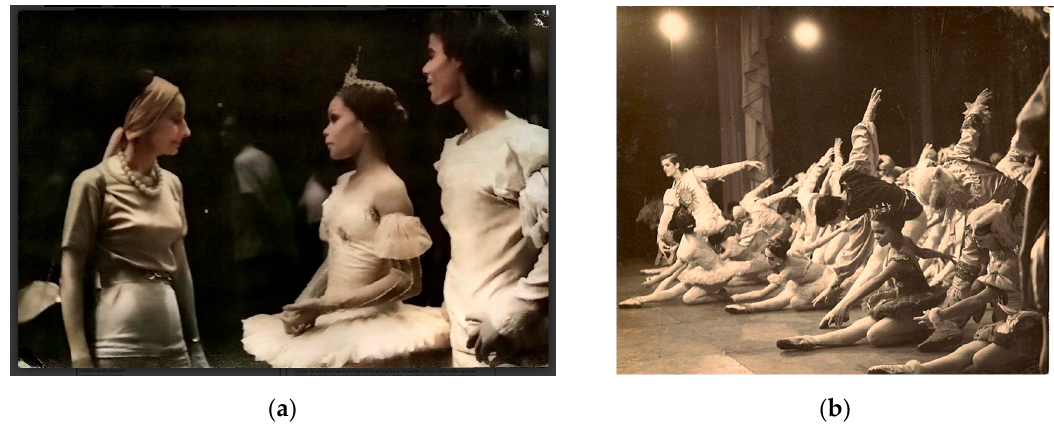
Figure 6. ( a ) Alicia Alonso, Caridad Martinez, and Lázaro Carreño in rehearsal for The Nutcracker , (scene of the snowflakes) at the Gran Teatro de La Habana, Federico Garcia Lorca. 1970; ( b ) Sleeping Beauty , Cuban National Ballet. Jorge Esquivel and Caridad Martinez are in the foreground. 1968. Published with the kind permission of Caridad Martinez.